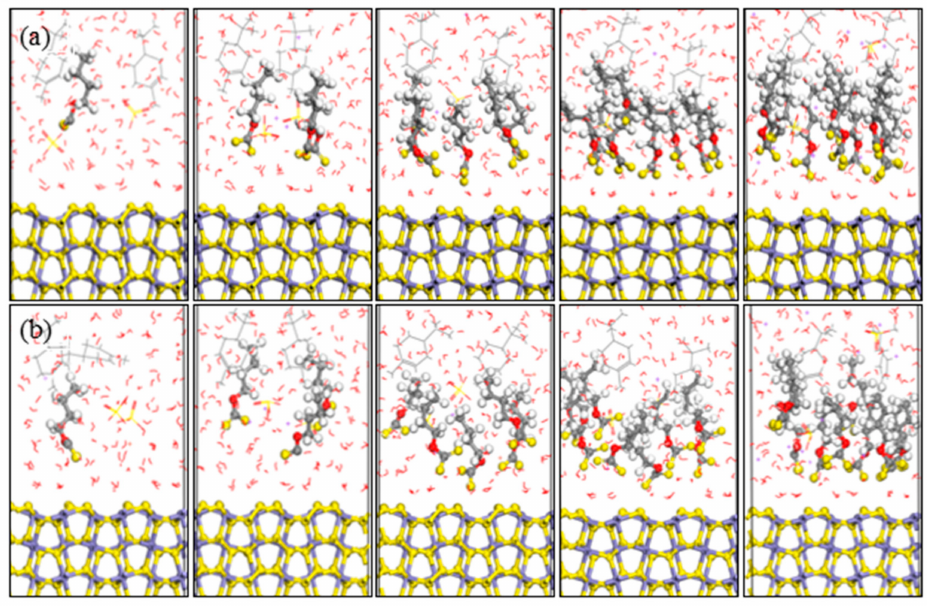
Figure 7. Equilibrium configurations of different butyl xanthate concentrations on pyrite surface in flotation chemistry ( a ) NVT; ( b ) NPT; (Color codes: red = O, white = H, yellow = S, grey = C, iron grey = Fe, purple = Na, brown = Cu; The above pictures is 1, 3, 5, 8, and 10 numbers of xanthate,